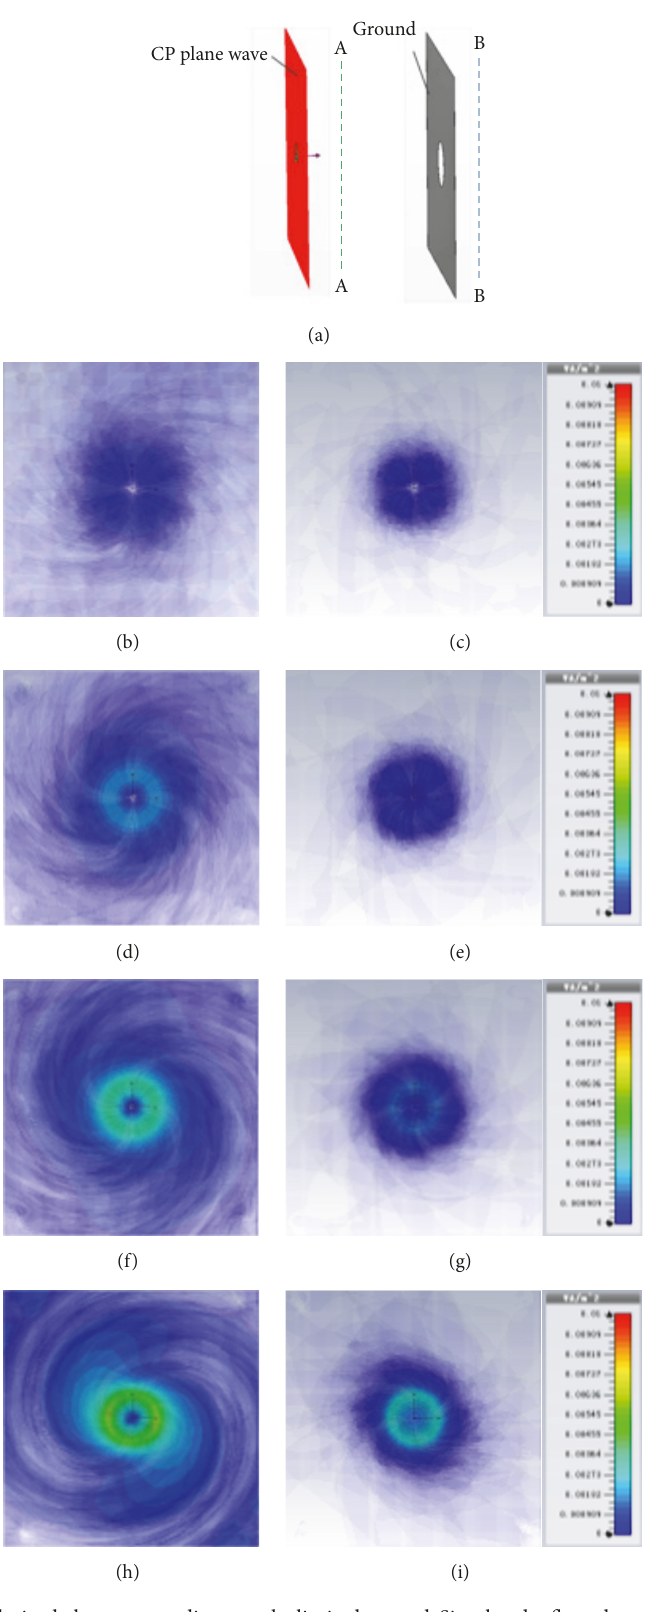
Figure 5: Case 1 : (a) circularly polarized plane wave radiates on the limited ground. Simulated reflected wave power flow density at (b) 4 GHz, (d) 6GHz, (f) 8GHz, and (h) 10 GHz. Simulated transmitted wave power flow density at (c) 4 GHz, (e) 6GHz, (g) 8 GHz, and (i) 10